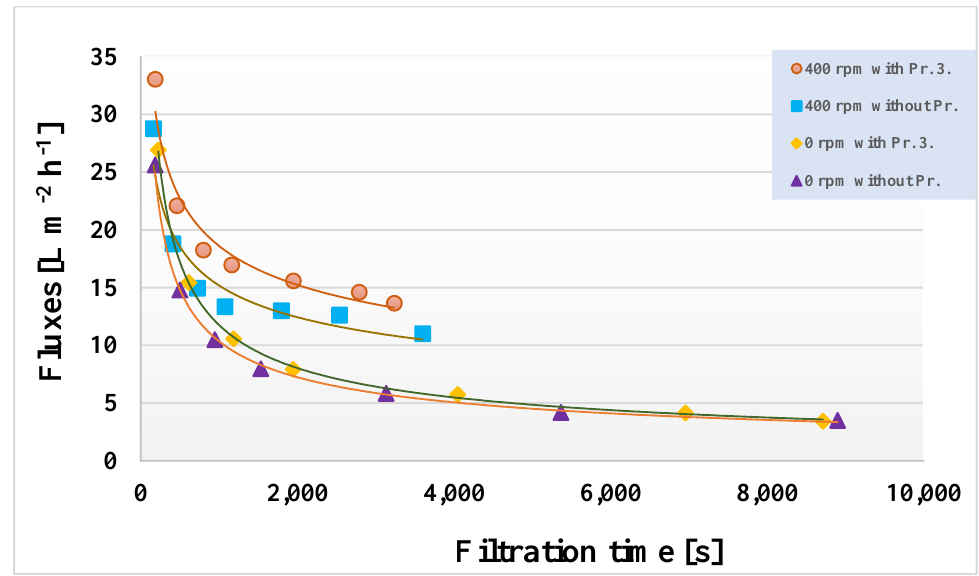
Figure 5. Ultrafiltration permeate flux values of 150 kDa membrane as a function of filtration time (T = 25 °C and TMP = 4 bar).